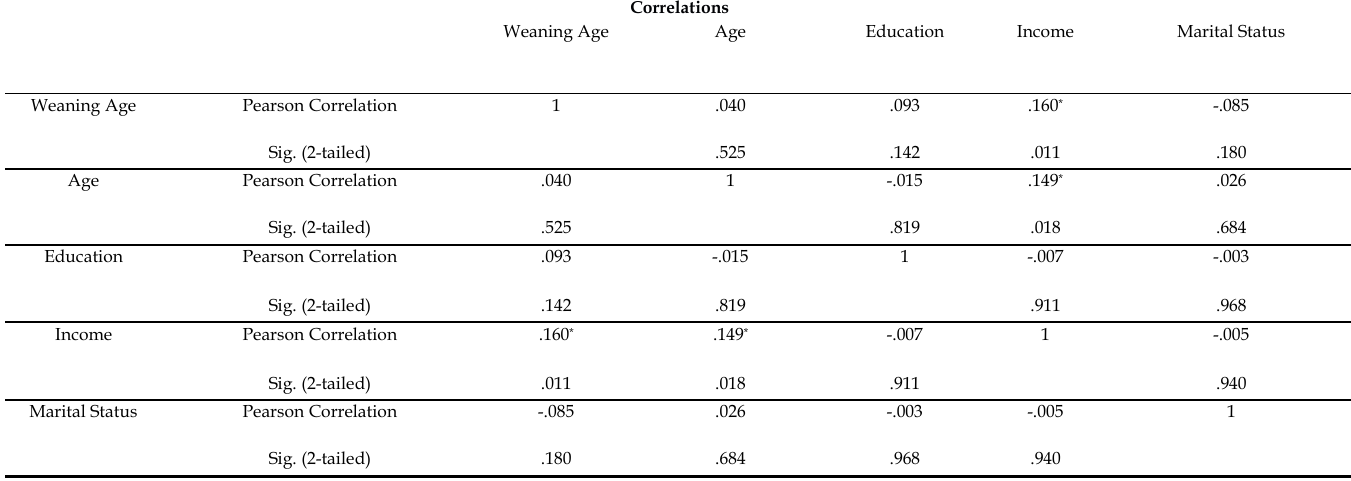
Correlation between socio-demographic characteristics and early child weaning among mothers (N = 251)